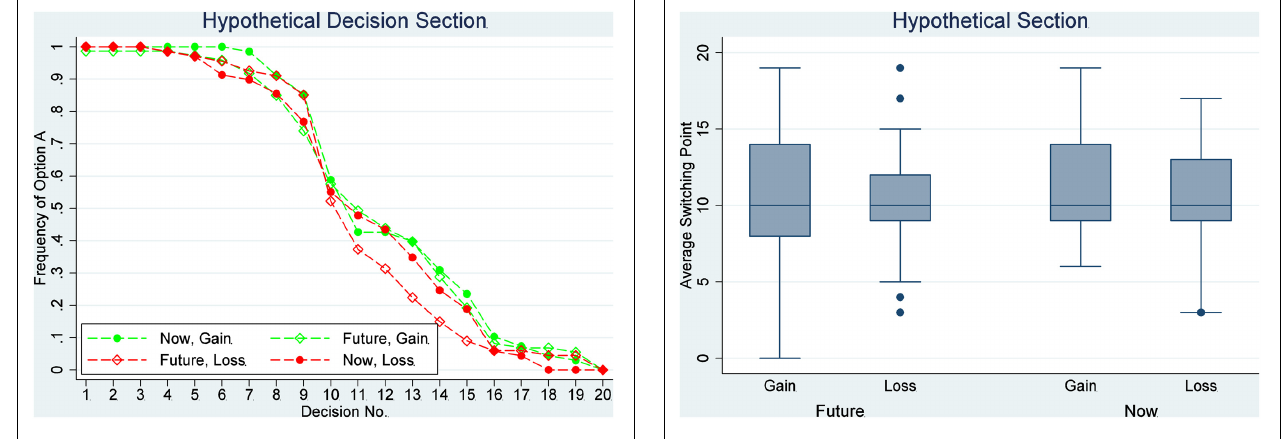
FIGURE 1 | Proportion of safe choices in each decision: the hypothetical decision.